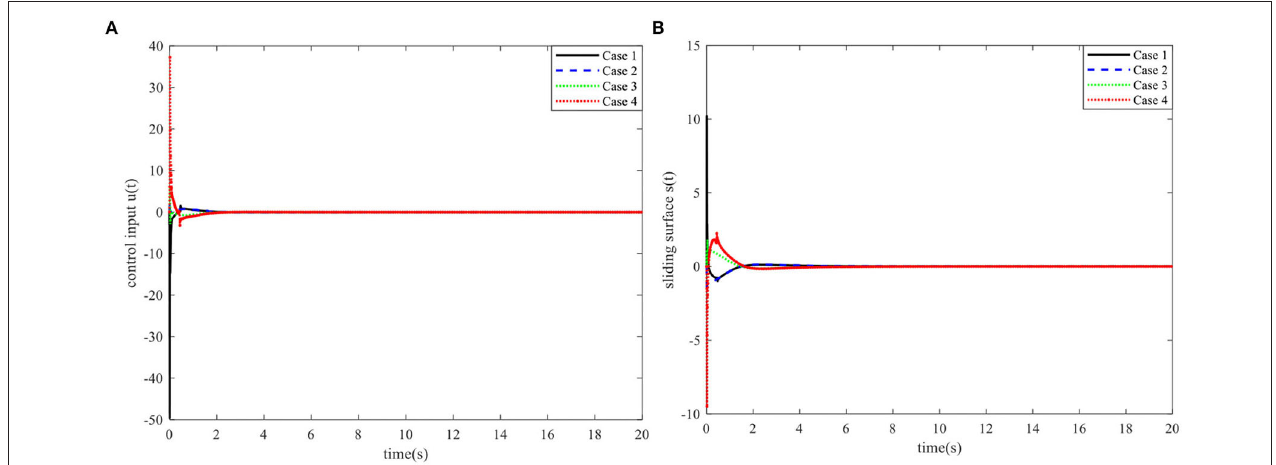
Frontiers in Neurorobotics |